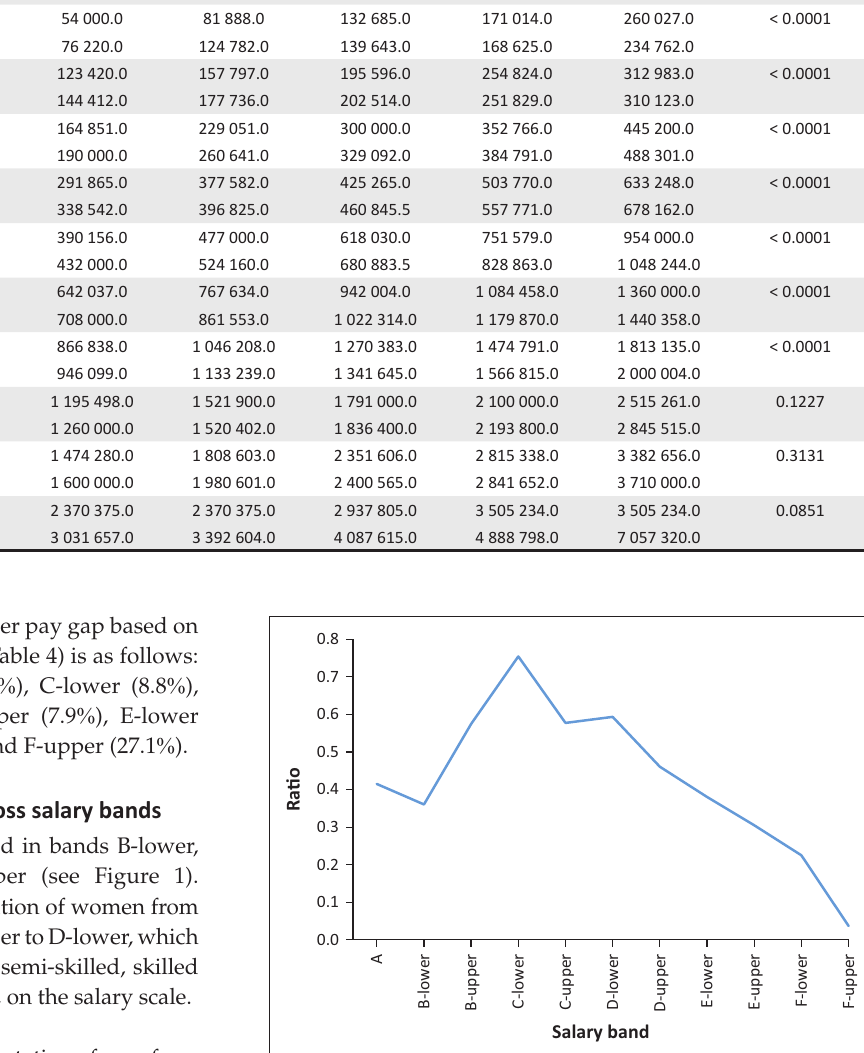
FIGURE 1: Trend of ratio of women to men by salary band.